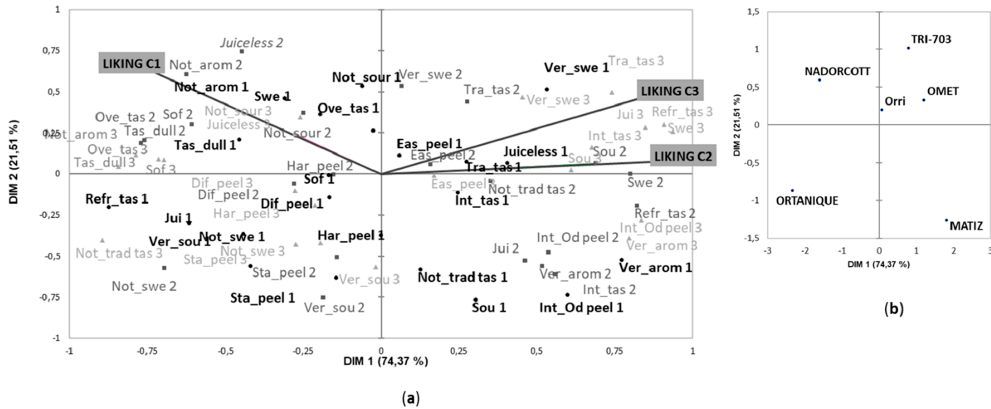
Figure 4. MFA of the CATA question in Harvest 2 considering responses for each of the three identified clusters as active datasets and mean liking scores as supplementary data: ( a ) vocabulary and liking (Cluster 1: black circle; Cluster 2: grey square; Cluster 3: light grey triangle); and ( b ) samples representation. DIM—dimension. Short forms of the CATA terms followed by numbers 1, 2 and 3 (corresponding to each cluster) appear in the MFA and their meanings are the following: Difficult to peel, Dif_peel ; Easy to peel, Eas_peel; Intense odor when starting to peel, Int_Od peel ; Stain hands when peeling, Sta_peel ; Hard starting peeling, Har_peel ; Very aromatic, Ver_arom ; Not very aromatic, Not_arom ; Refreshing taste, Refr_tas ; Not traditional/novel taste, Not_trad tas ; Not very sweet, Not_swe ; Sweet, Swe ; Very swee, Ver_swe ; Tasteless/dull, Tas_dull ; Very intense taste, Int_tas ; Traditional mandarin taste, Tra_tas ; Not very sour, Not_sour ; Sour, Sou ; Very sour, Ver_sou ; Juicy, Jui ; Soft, Sof ; Overripe taste, Ove_tas ; Juiceless, Juiceless.